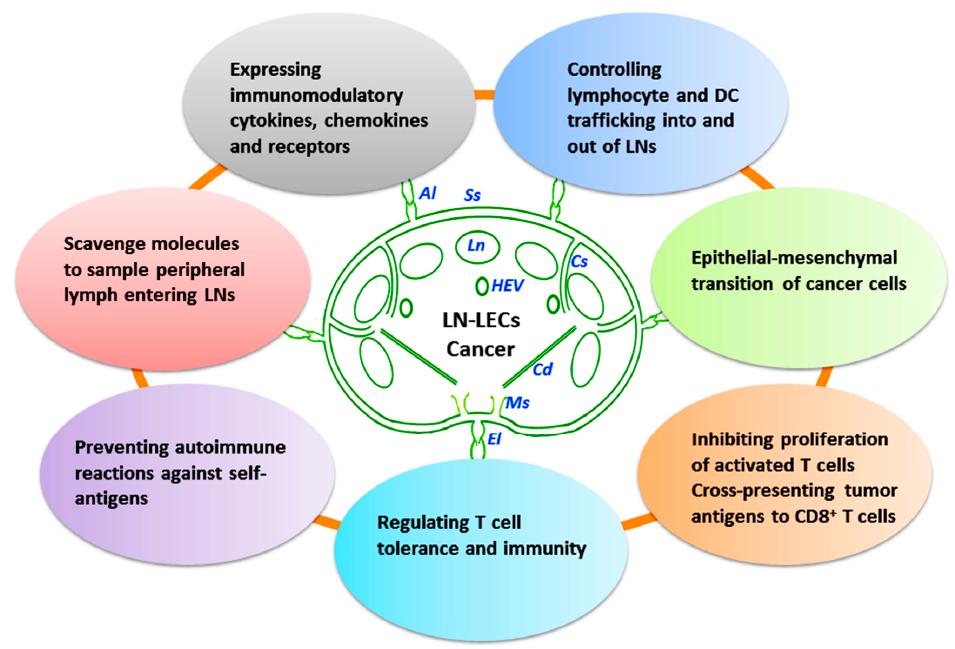
Figure 2. Involvement of LN-LECs in immune functions. LN-LECs in tumor microenvironment are actively involved in immunological responses. Al: afferent lymphatics; Ss: subcapsular sinuses; Cs: cortical sinuses; Ms: medullary sinuses; El: efferent lymphatics; Ln: lymph nodules; HEV: high endothelial venules; Cd: conduits.